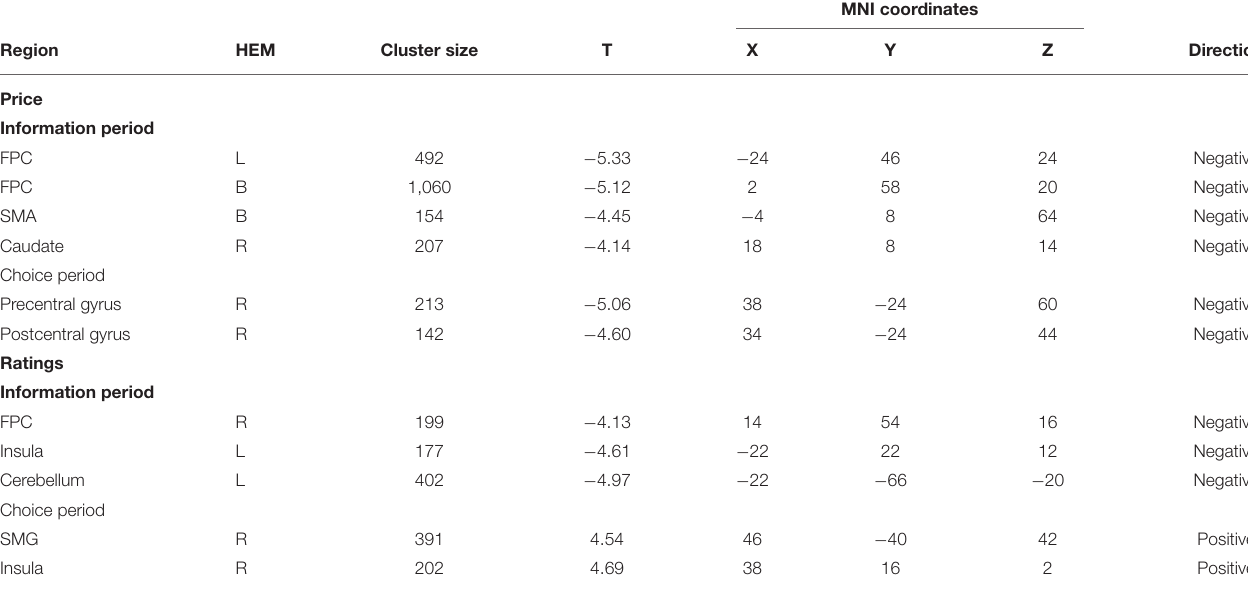
MNI coordinates